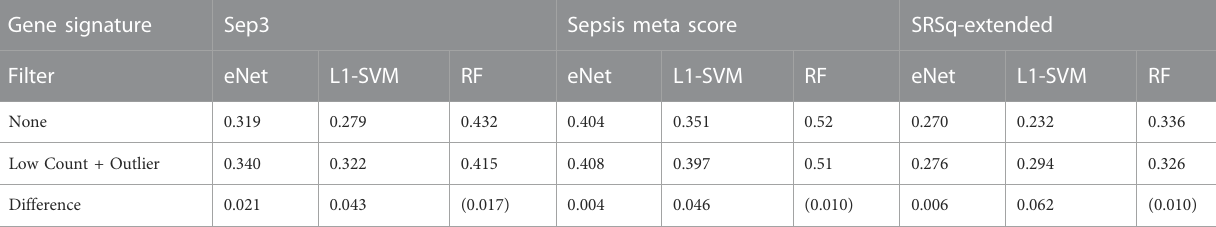
TABLE 4 Mean correlation between genes identi fi ed and known sepsis biomarker signatures. Gene